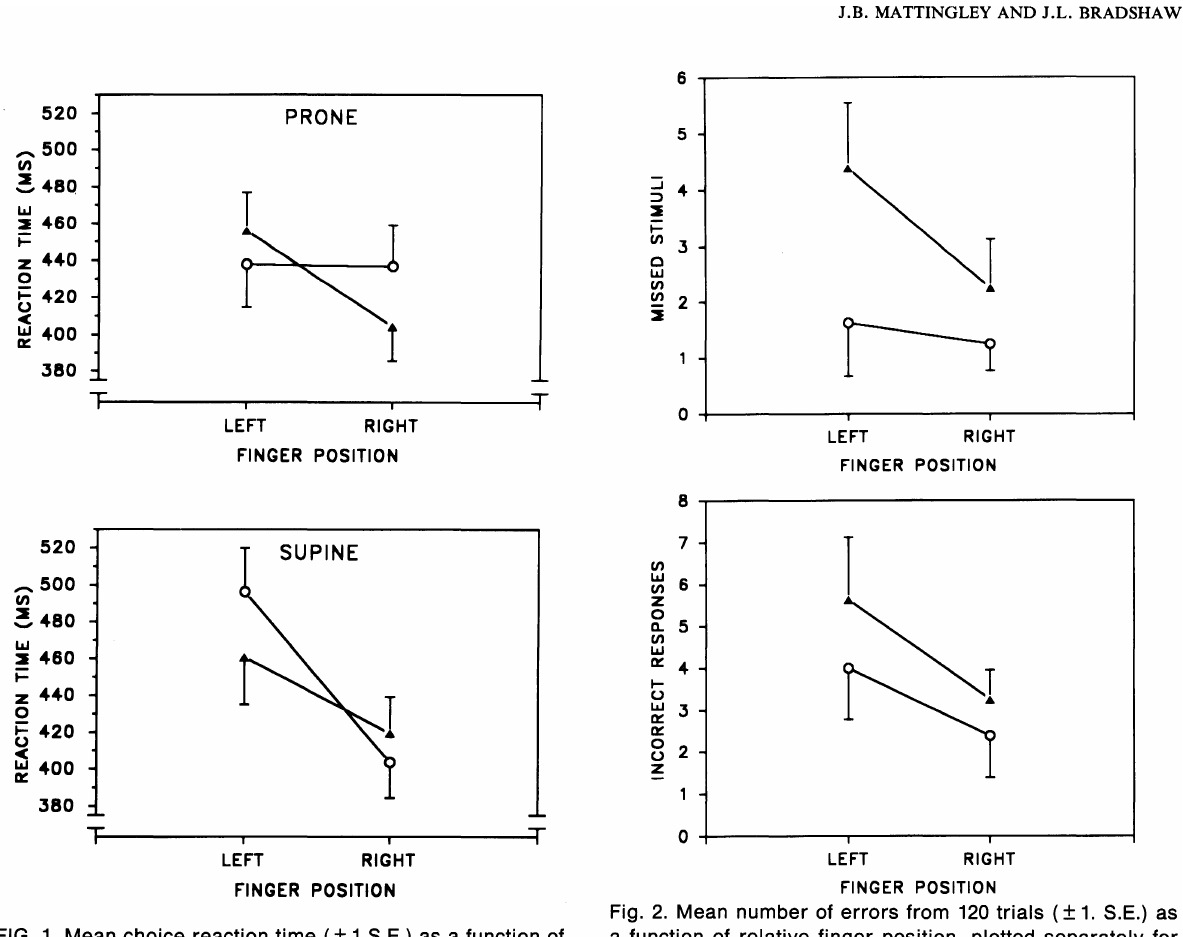
FIG. 1. Mean choice reaction time (± 1 S.E.) as a function of relative finger position, plotted separately for prone (above) and supine (below) postures. Open circles: controls; filled triangles: RH damaged patients.